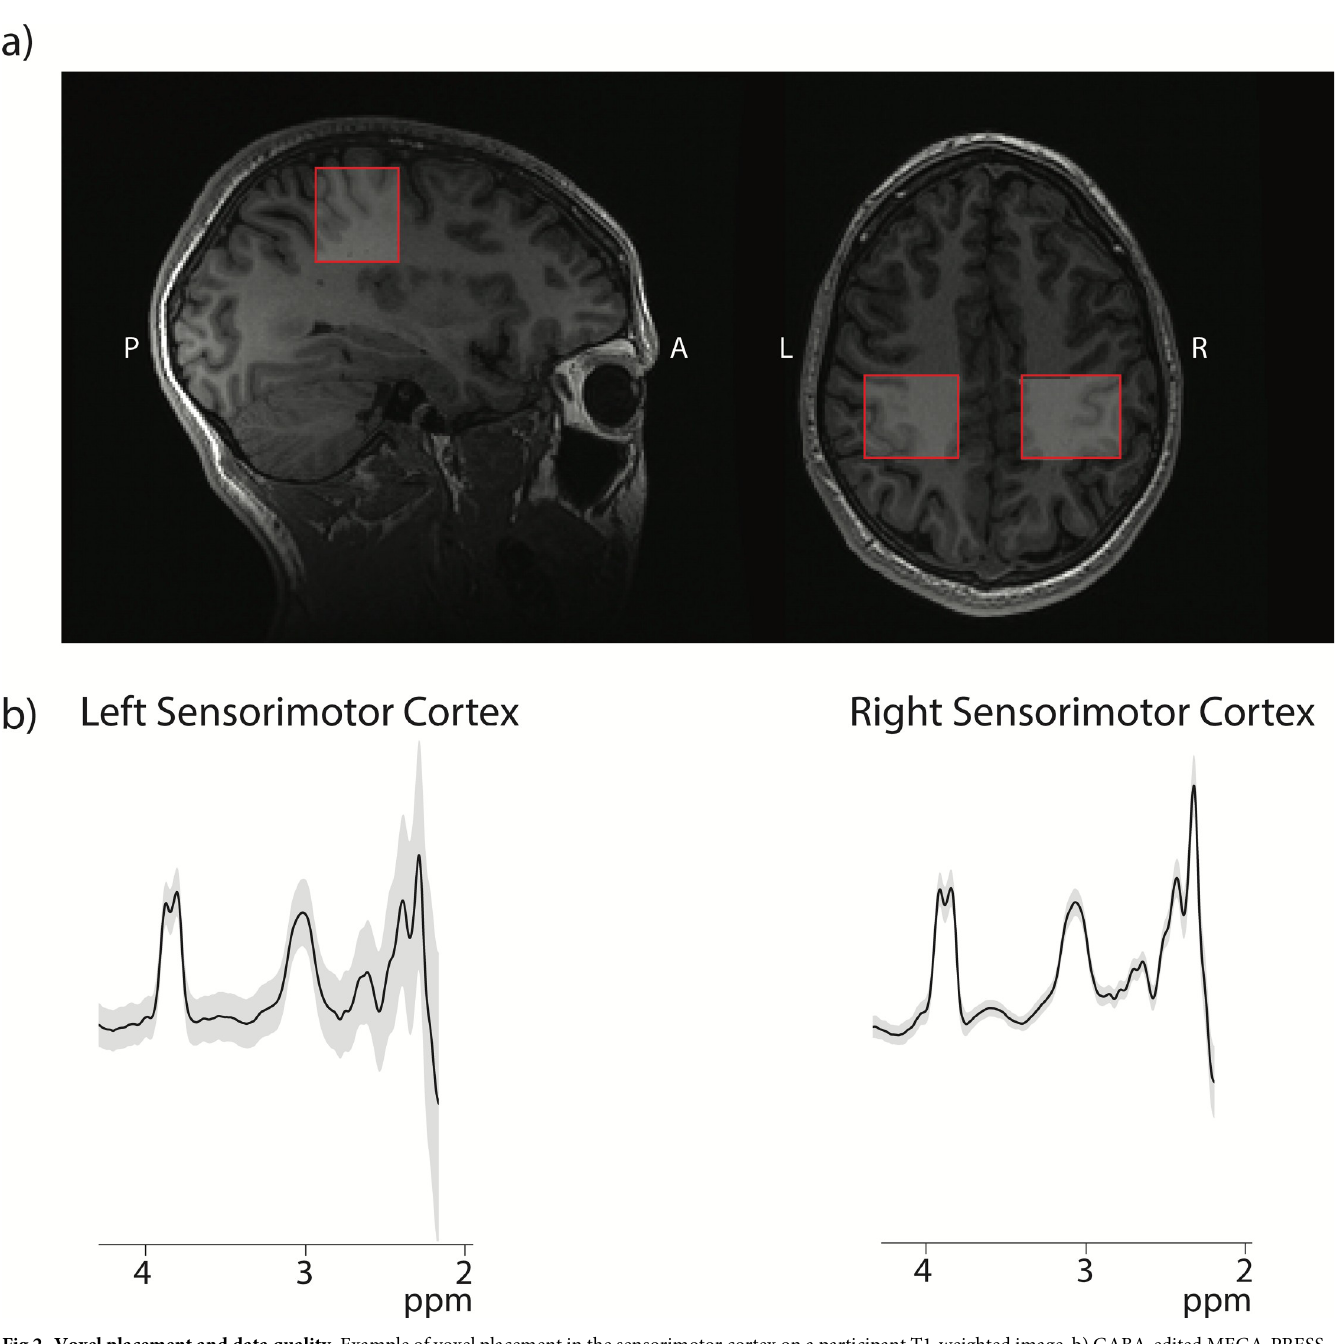
Fig 2. Voxel placement and data quality. Example of voxel placement in the sensorimotor cortex on a participant T1-weighted image. b) GABA-edited MEGA-PRESS spectra acquired in each location. The black line depicts the average fit line and the grey area shows ± 1 standard deviation in the right and left sensorimotor cortex.